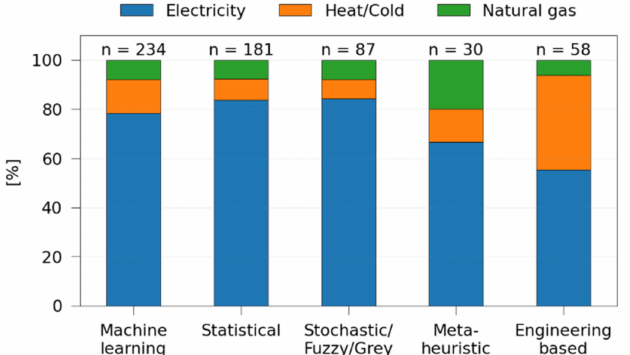
Figure 3. The relative share of energy carriers within each category of techniques. The relative share of appearances of each energy carrier within each of the five major categories of techniques (see Section 3) is shown along with the total number of appearances (n) of each category. Approaches like ML and statistical techniques are used the most and are largely applied to model electricity consumption. These methods mainly rely on historic consumption data, which is particularly well available for electricity consumption. Engineering-based approaches are used less frequently overall but are suited to model heat/cooling demand, especially in the context of building